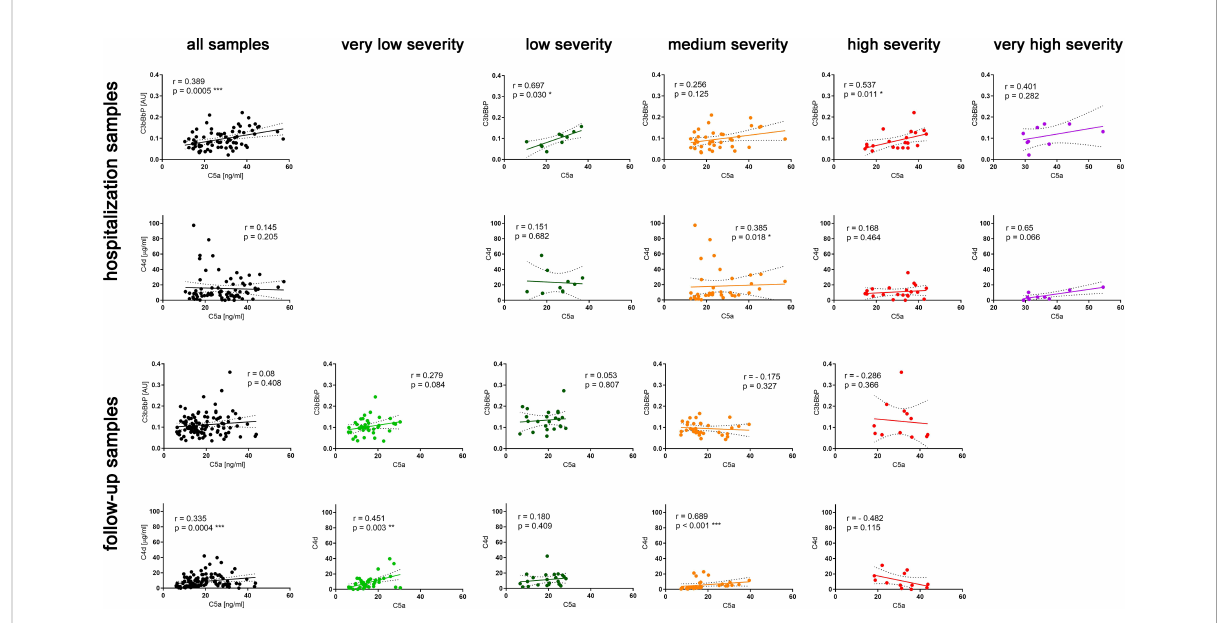
FIGURE 2 Correlations of C5a with C3bBbP and C4d readouts in hospitalization and follow-up serum samples. Spearman r coef fi cients and p values were calculated for all hospitalization and follow-up samples and separately for each severity group. The 95% con fi dence band of the best- fi t line is shown. Symbols *, **, and *** denote statistical signi fi cance at p level <0.05, <0.01, or < 0.001, respectively.